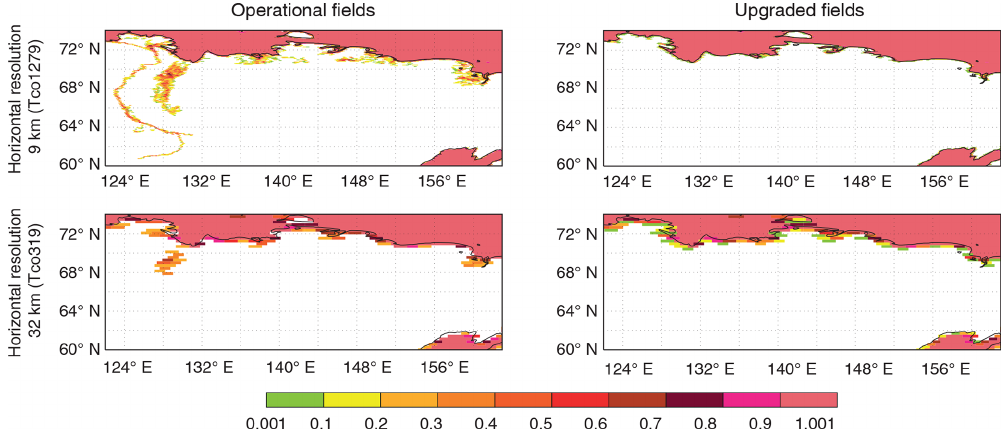
Figure 2. Same as Fig. 1 but over north-eastern Russia (60–74 ◦ N, 122–163 ◦